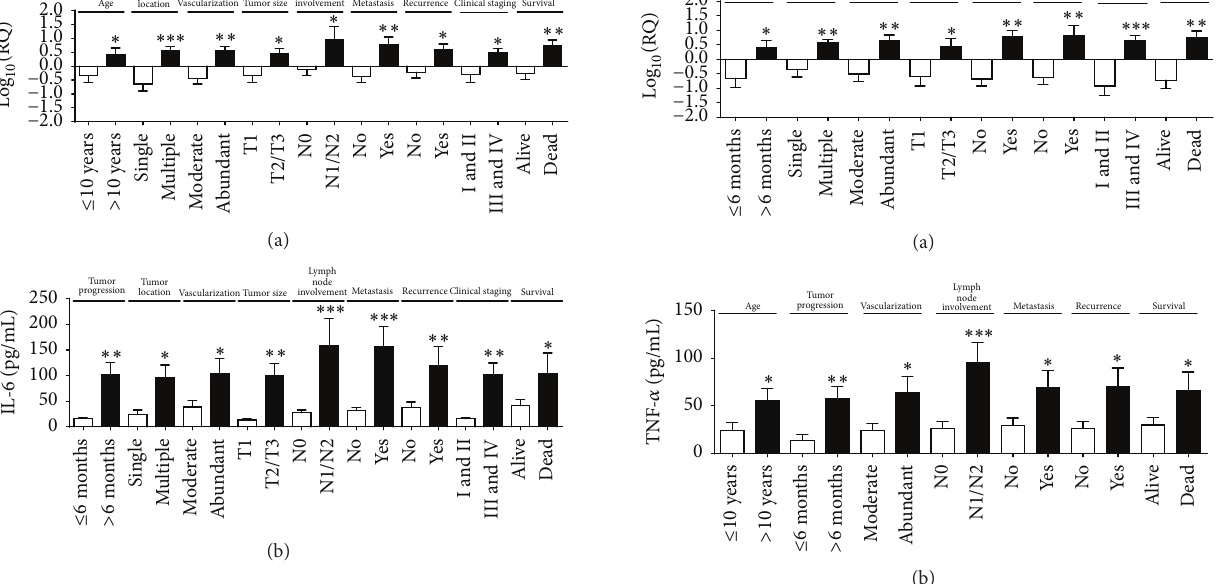
Figure5: IL-6 geneoverexpressioncorrelatedwith(a)age ≤ 10years; multiple tumor locations; abundant tumor vascularization; tumor mass size greater than 3 cm; lymph node involvement; metastasis; recurrence; clinical staging III or IV; and animals that died. Higher IL-6 protein levels correlated with (b) tumor progression for more than 6 months; multiple tumor locations; abundant tumor vascular- ization;tumormasssizegreaterthan3 cm;lymphnodeinvolvement; metastasis; recurrence; clinical staging III or IV; and animals that died. Error bars ± standard error; ∗ 𝑝 < 0.05 ; ∗∗ 𝑝 < 0.01 ; ∗∗∗ 𝑝 < 0.001 indicate significant differences according to Student’s 𝑡 -test.